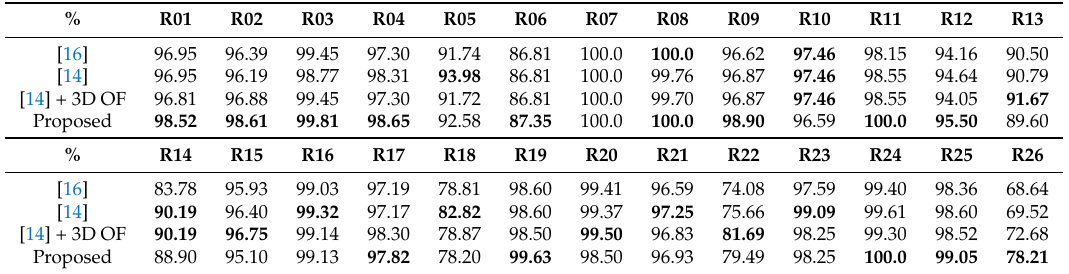
Table 4. AP for PCK with α = 0.05, for each of the 26 reflectors, after filtering.